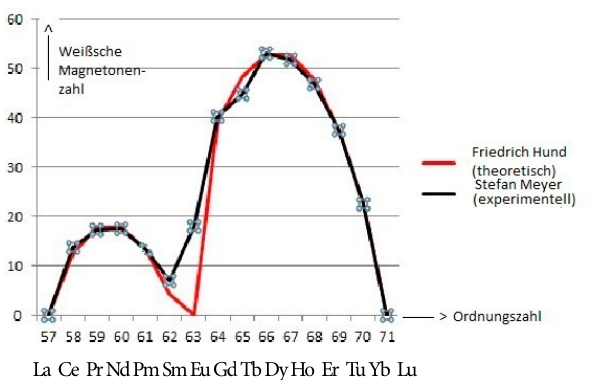
Fig. 8 Magnetic properties of the rare earth elements (trivalent ions of 57 lanthanum to 71 lutetium). Source 63 : Friedrich Hund, Atomtheo- retische Deutung des Magnetismus der Seltenen Erden (= Theoreti- cal atomic signification of magnetism of the rare earths), Zeitschrift für Physik , 1925 , 33, Table 1, p.